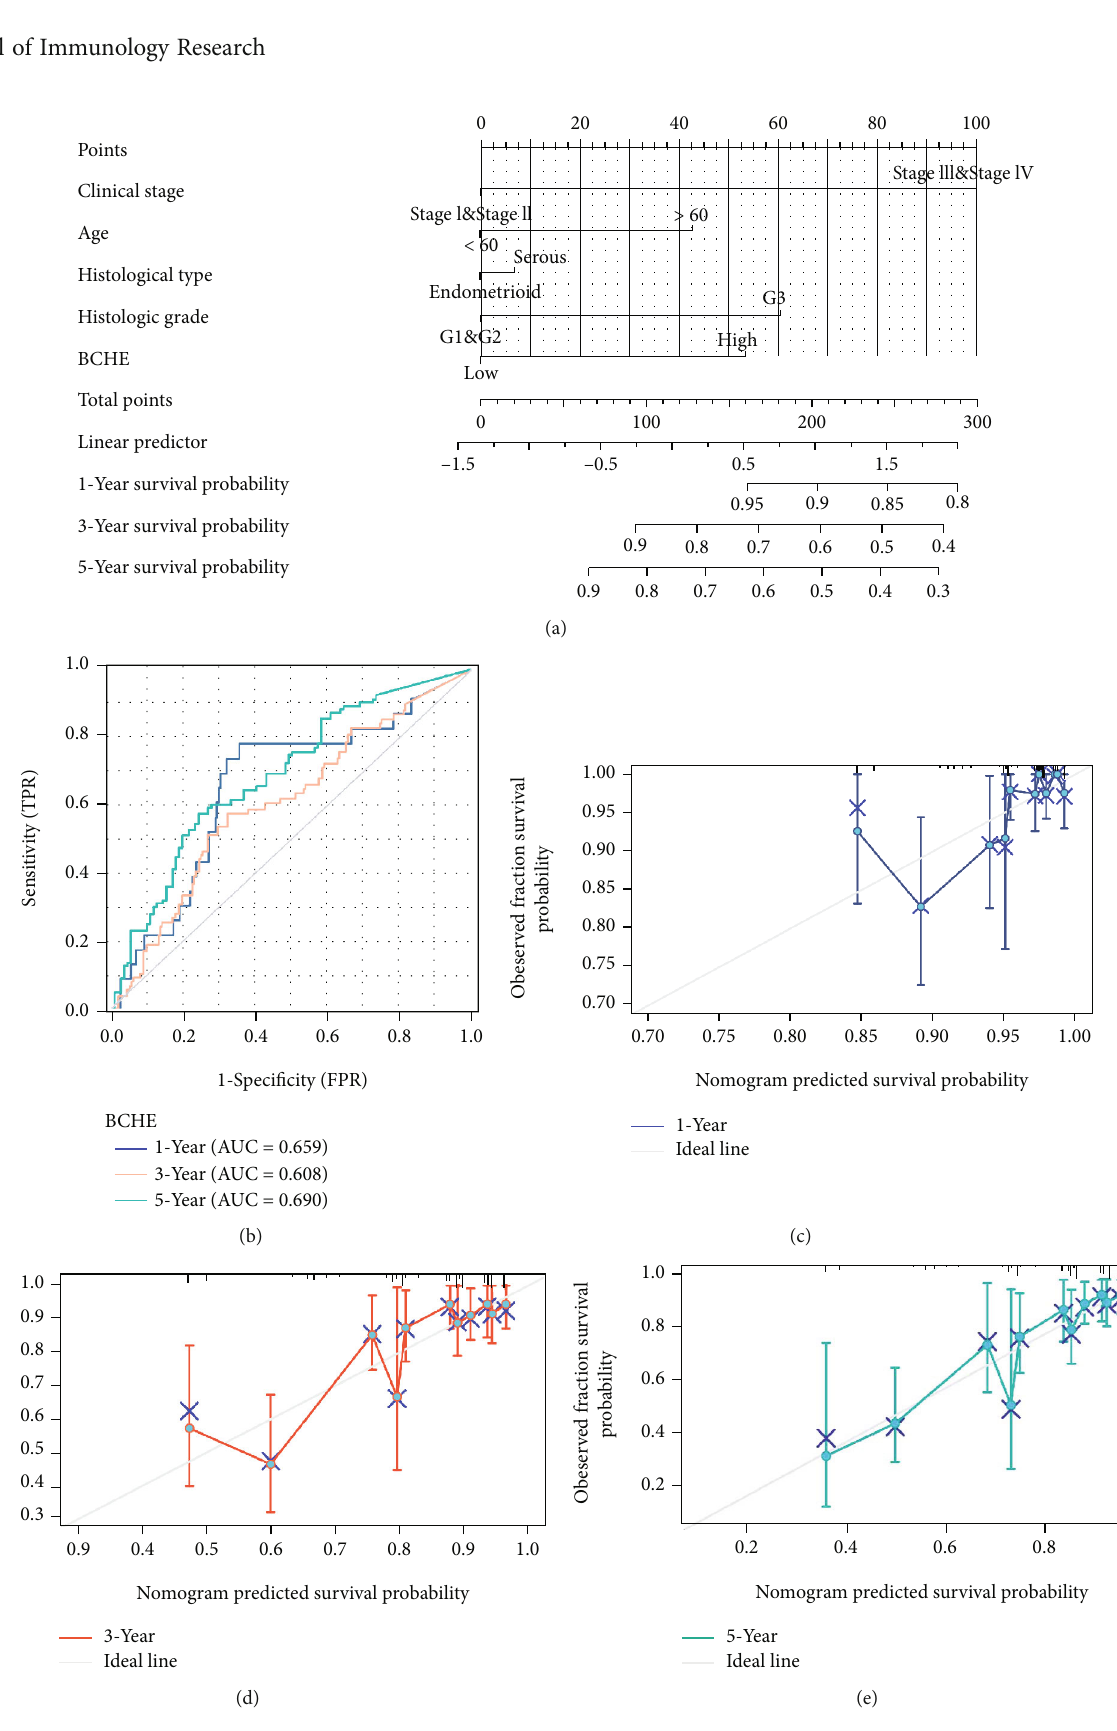
Figure 4: Nomogram construction and evaluation. (a) Nomogram construction based on BCHE and clinicopathological variables. (b) ROC curves of BCHE. (c) Calibration curves of 1 year. (d) Calibration curves of 3 years. (e) Calibration curves of 5